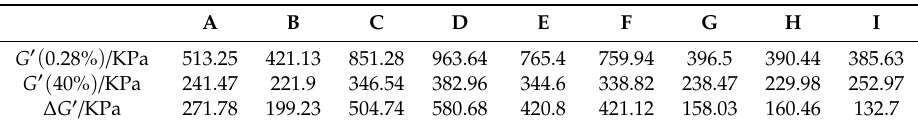
Table5. The test results of Payne effect of composites. Table 5. The test results of Payne e ff ect of composites.